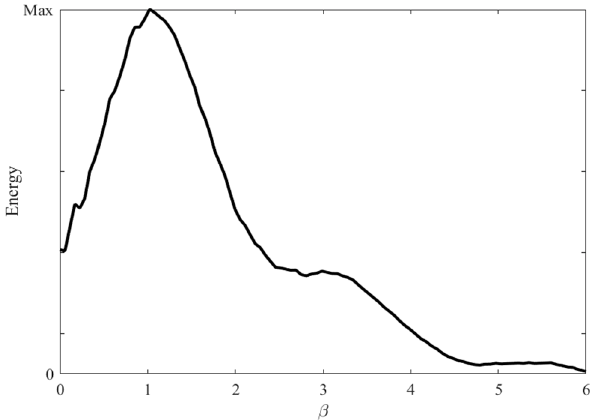
Figure 4. Experimentally obtained energy distribution of waveguide invariant 𝛽 corresponding to 200–300 Hz frequency band.